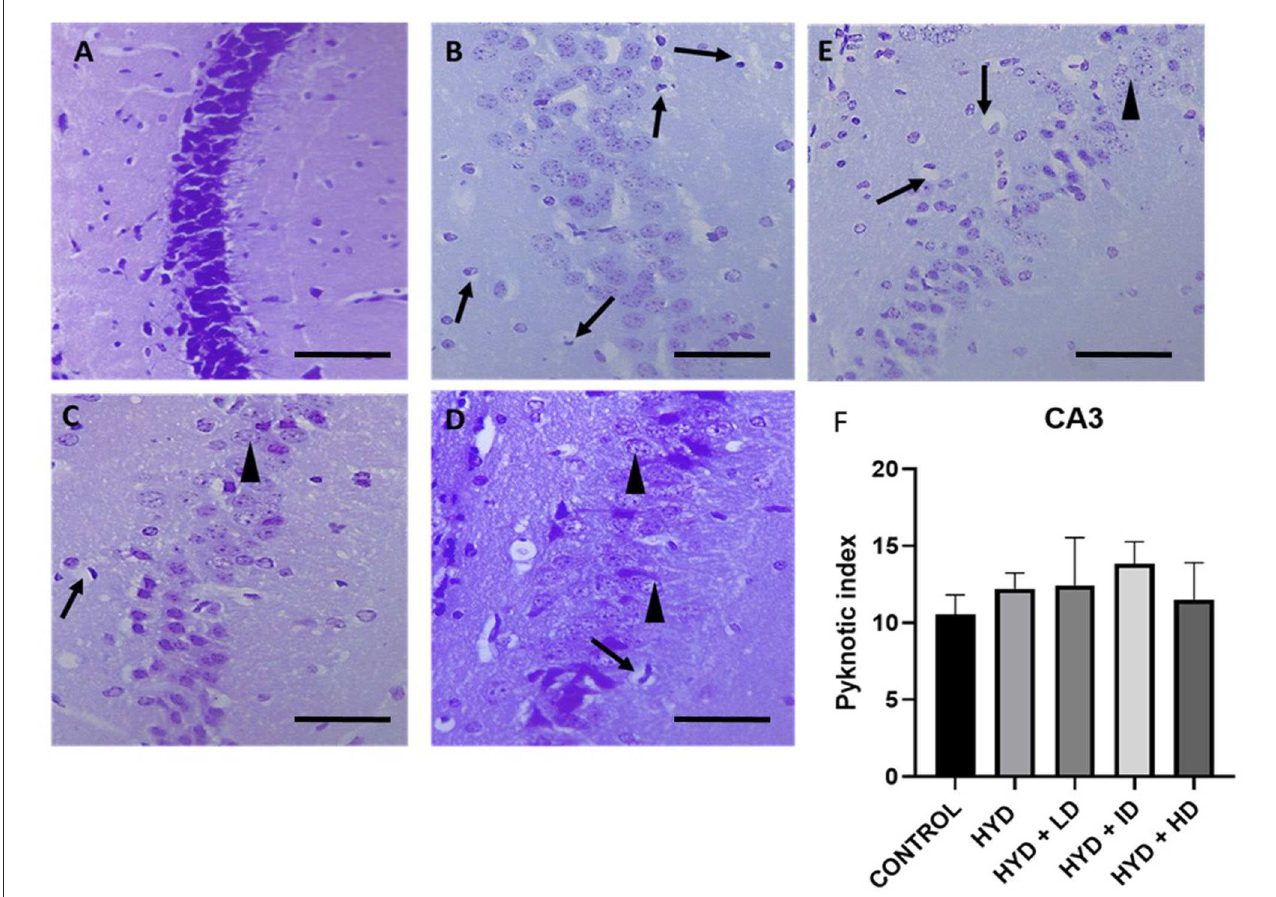
FIGURE5 Photomicrograph of Cresyl stained CA3 region of the hippocampus of control and experimental mice. (A) Control, (B) hydrocephalus only (HYD), (C) hydrocephalus + low dose vanadium (HYD + LD), (D) hydrocephalus + intermediate dose vanadium (HYD + ID), (E) hydrocephalus + high dose vanadium (HYD + HD), and (F) bar chart showing the pyknotic index of the CA3 region of the hippocampus of the control and experimental groups. There was no significant difference in the pyknotic index in the CA3 region among all the groups (arrows, pyknotic neurons; arrowheads, normal neurons; Scale bar, 4 µ